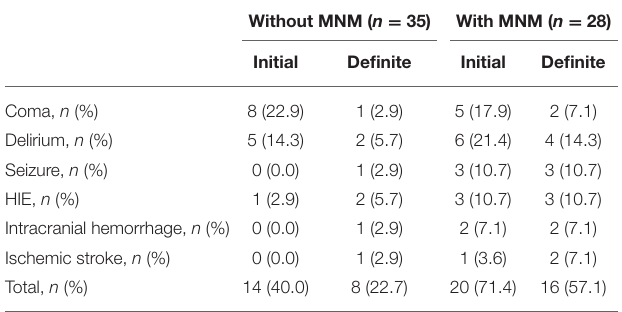
TABLE 2 | Neural impairment in patients with VA-ECMO support.